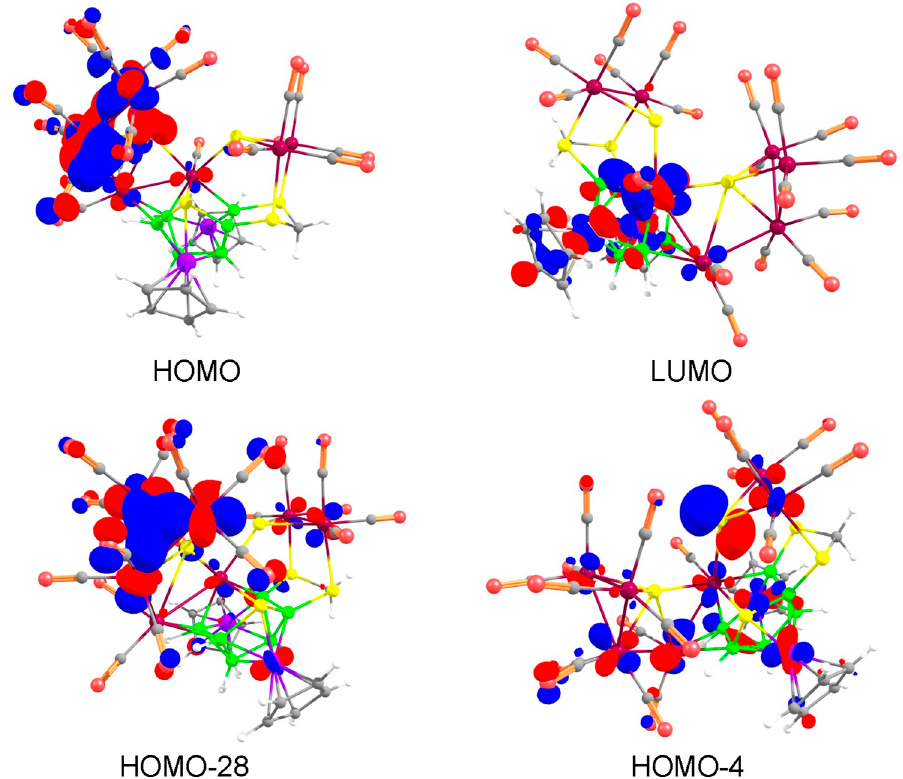
Figure 5. Key frontier molecular orbitals of 7 . Contour values for isosurface are ± 0.04 (e/bohr 3 ) 1/2 .